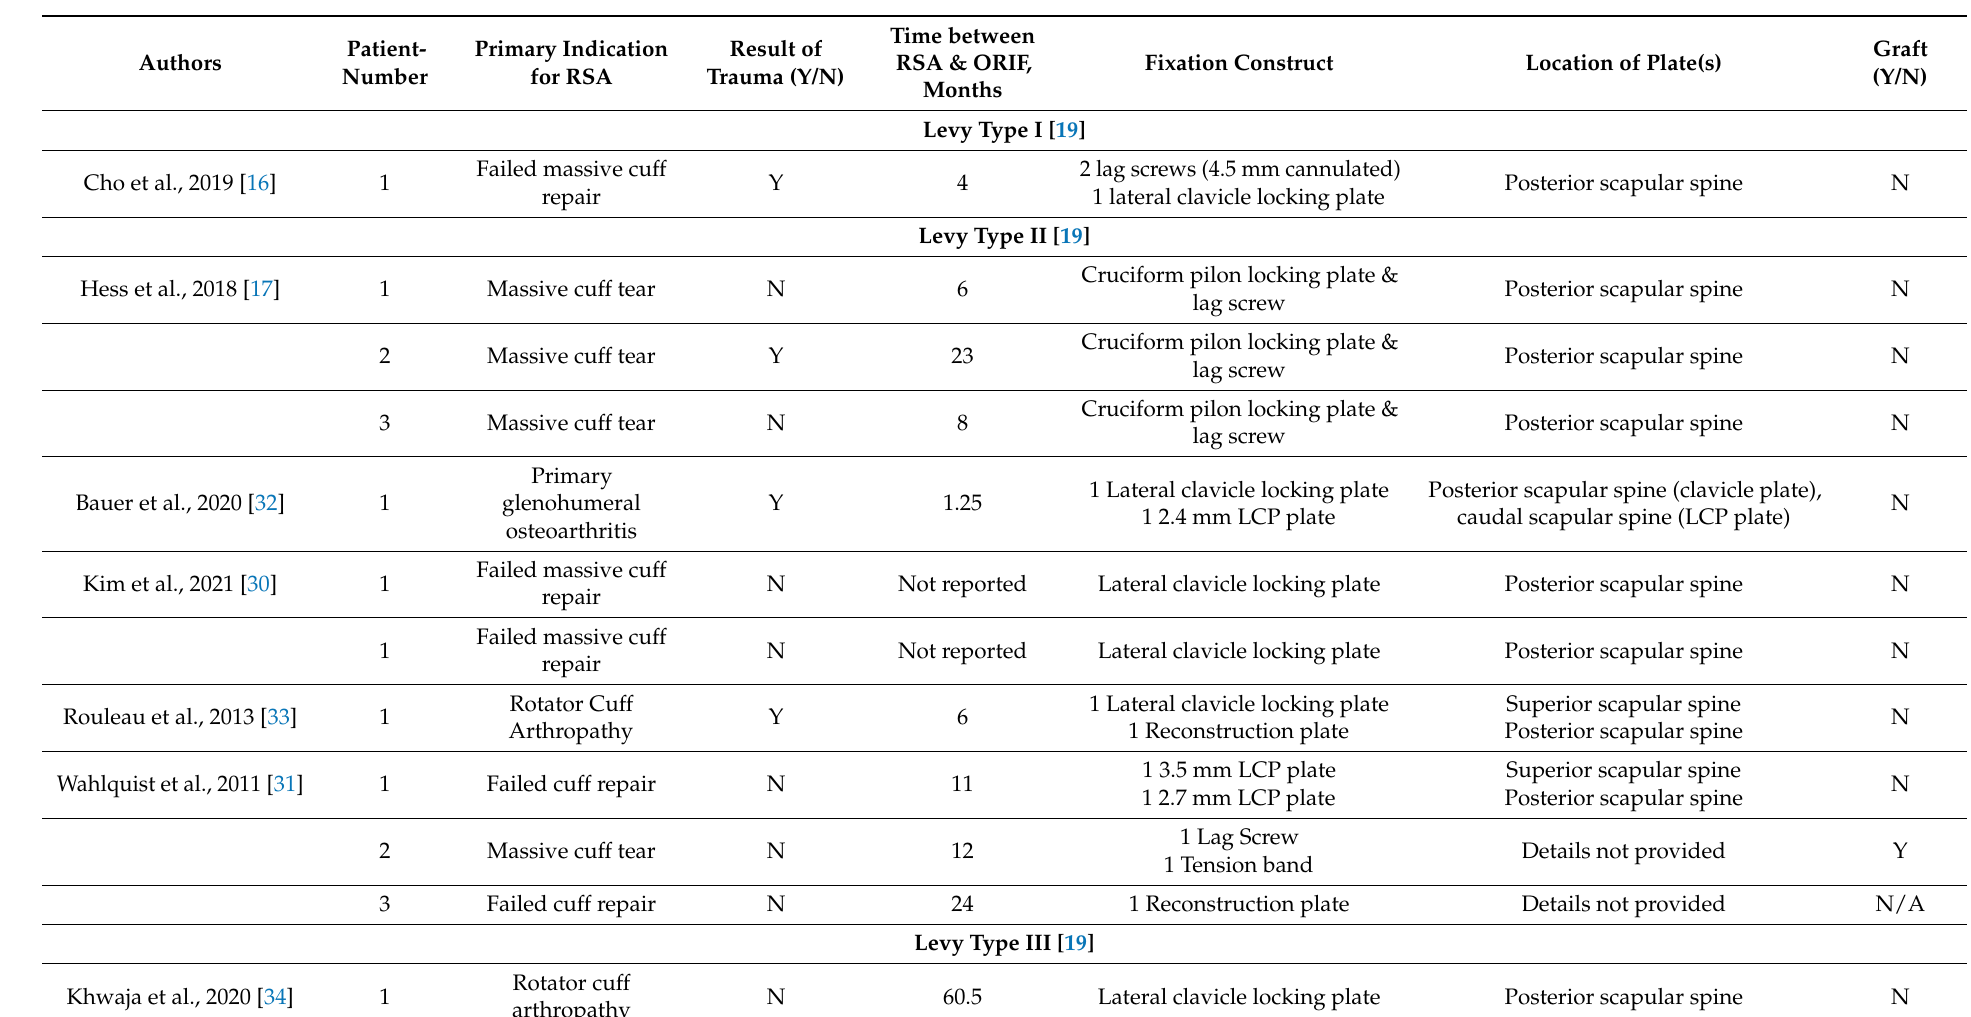
Table 2. Fixation constructs according to fracture